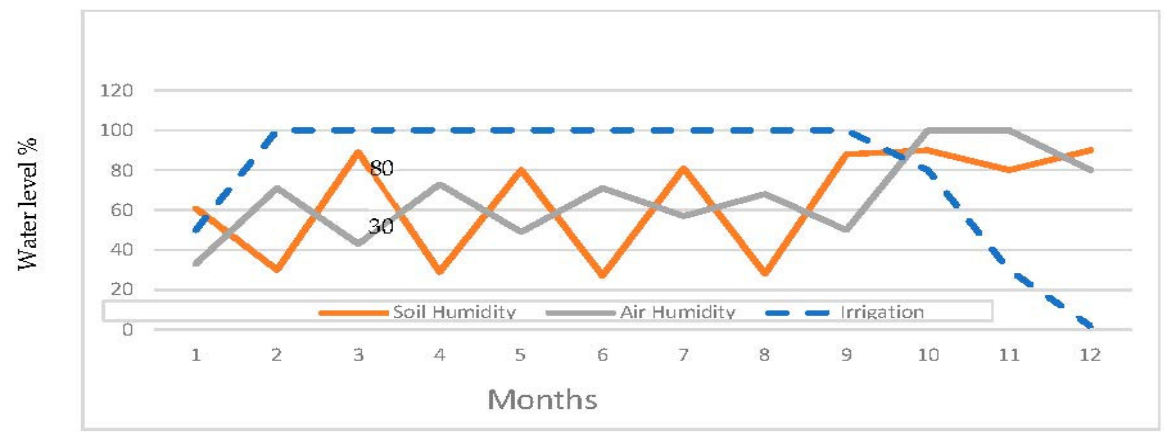
Figure 6. Data collected during the whole year in Saudi